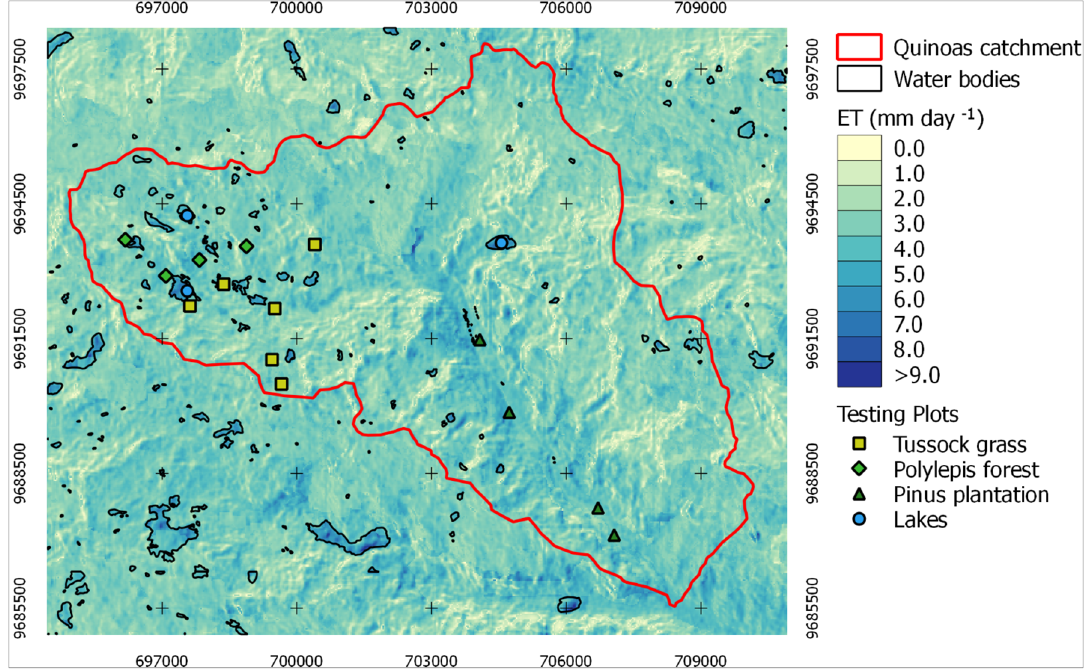
Figure 5. METRIC L ET map for 19 October 2013 (cloud-free day).